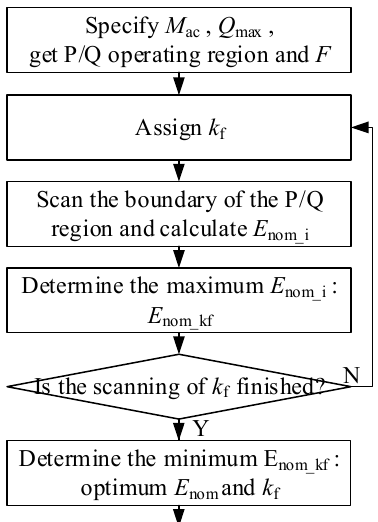
Figure 8. Computing process of capacitor usage and FBSM quantity.